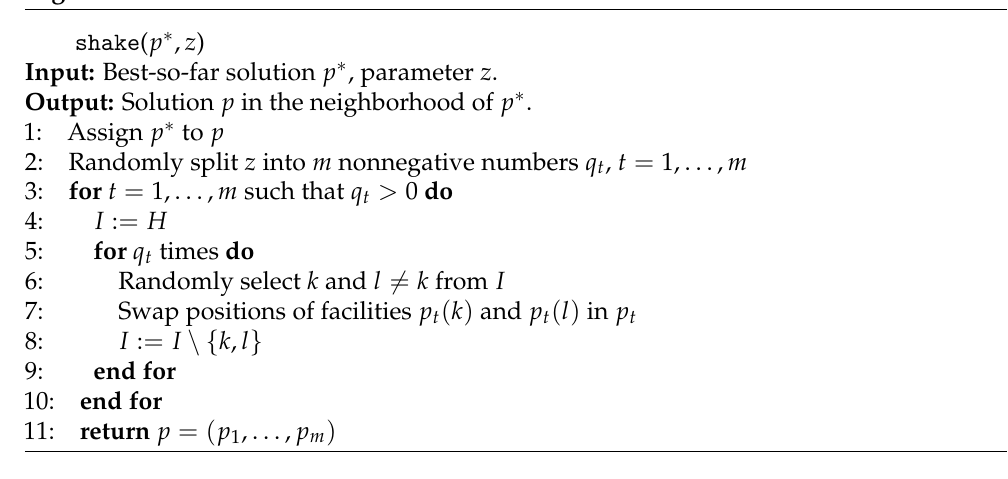
Algorithm 2 Shake function shake ( p ∗ , z )